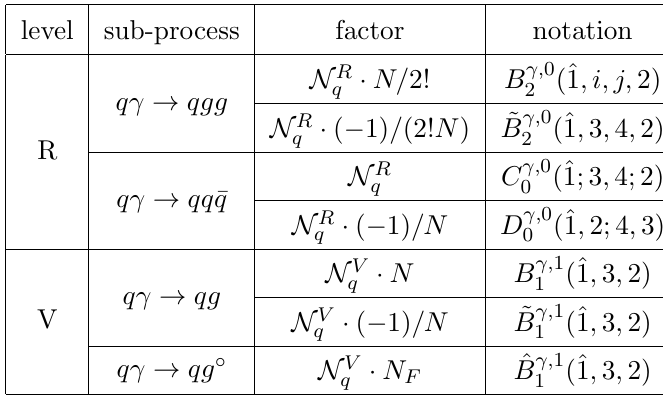
Table 2 . Summary of the quark-channel partonic sub-processes and colour factors for the NLO calculation. Non-numeric arguments denote summation of gluon permutations. e.g. the matrix ele- (^1 ; i; j; 2) includes a summation f i; j g 2 P (3 ; 4) where P denotes the set of permutations. ment B (cid:13); 0 2 Each (cid:14) denotes a closed quark loop.